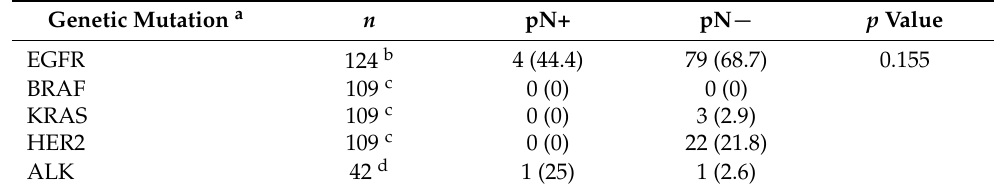
Table 2. Results of somatic